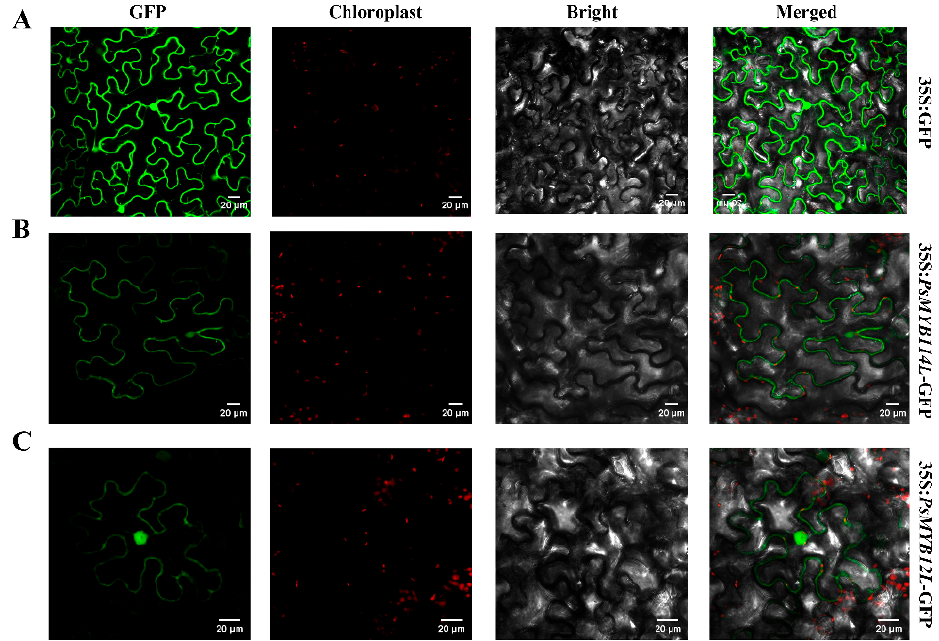
Figure 4. Subcellular localization analysis of the PsMYB114L and PsMYB12L genes. ( A ) Control vector (pCAMBIA1301-GFP) expressed in epidermal cells of tobacco leaves. ( B ) Recombinant vector ( PsMYB114L -GFP) expressed in epidermal cells of tobacco leaves. ( C ) Recombinant vector ( PsMYB12L -GFP) expressed in epidermal cells of tobacco leaves. White lines at the bottom right of the picture represent 20 µ m in the respective pixel. GFP, GFP fluorescence; Chloroplast, Chloroplast fluorescence; Bright, Bright field; Merged, Superposition of bright field and